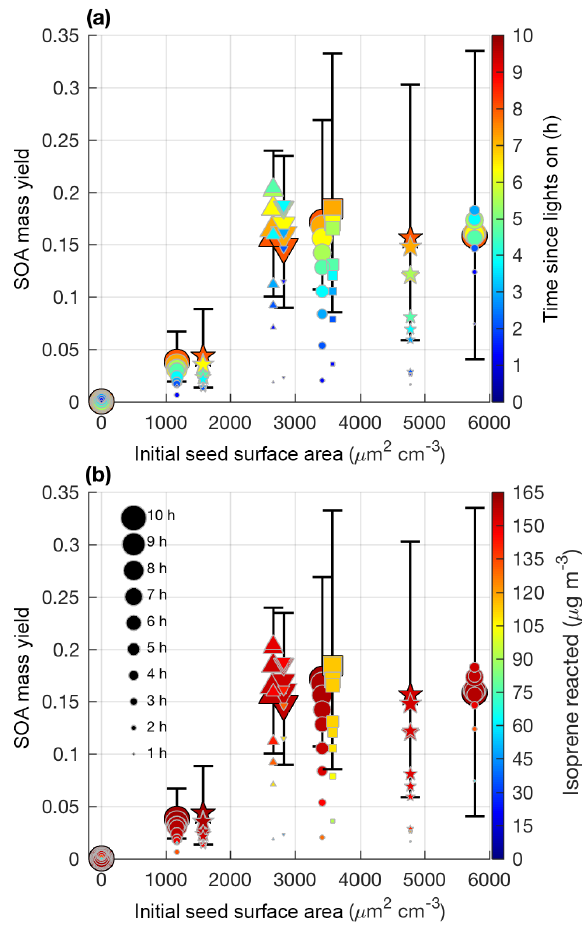
Figure 5. SOA mass yield (60min averages) as a function of initial seed surface area for all LV pathway experiments. Colors represent time since lights on in panel (a) and extent of isoprene reacted in panel (b) . Marker size represents time since lights on. Uncertainty is shown in black lines as described in Sect. 4.1. Marker types in- dicate 25–26 ◦ C (dot), 13 ◦ C (inverted triangle), 32 ◦ C (triangle), lower loadings of isoprene (square), and new chamber with less wall charging